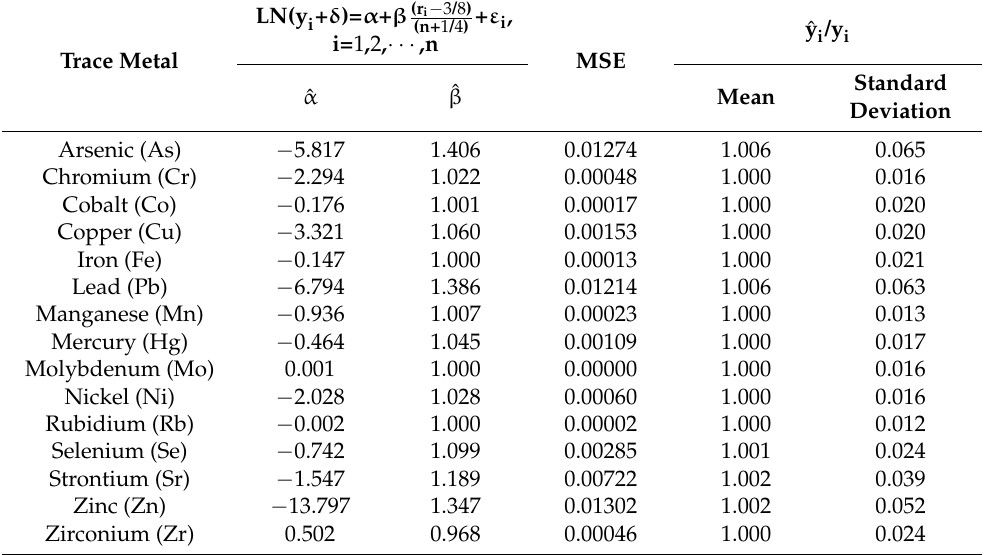
Table A1. Selected descriptive statistics for calculating and assessing the theoretical error of the 15 trace metals measured via Syracuse soil sample assaying.